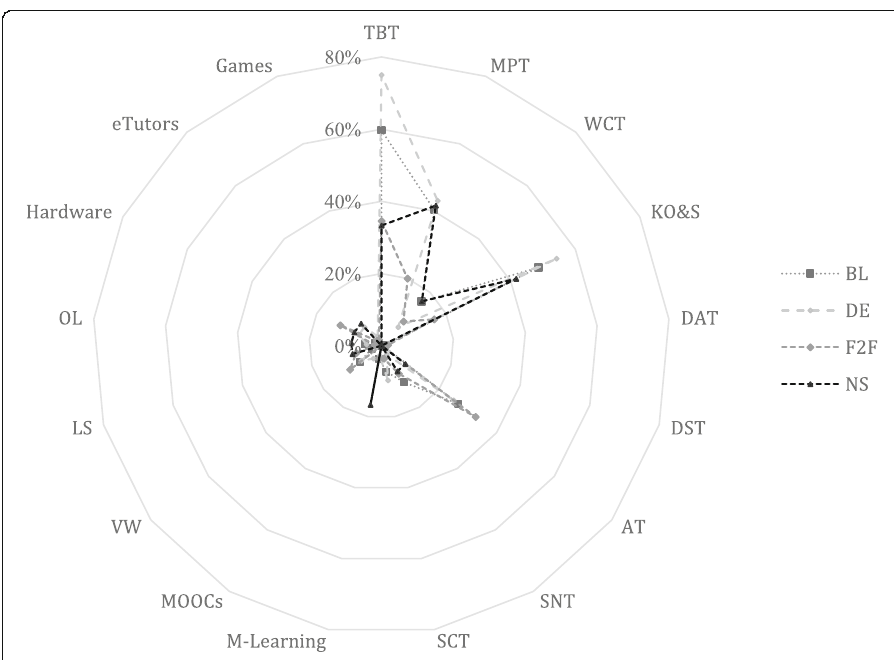
Fig. 10 Relative frequency of educational technology tools used according mode of delivery. Note. Tool abbreviations as per Figure 10. BL = Blended learning; DE = Distance education; F2F = Face-to-face; NS = Not